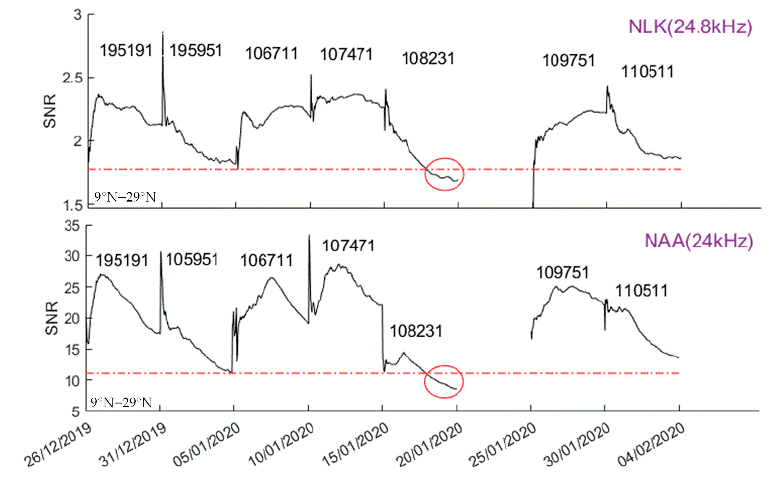
Figure 5. Orbit 108,231 and its revisited orbit SNR variation graph.